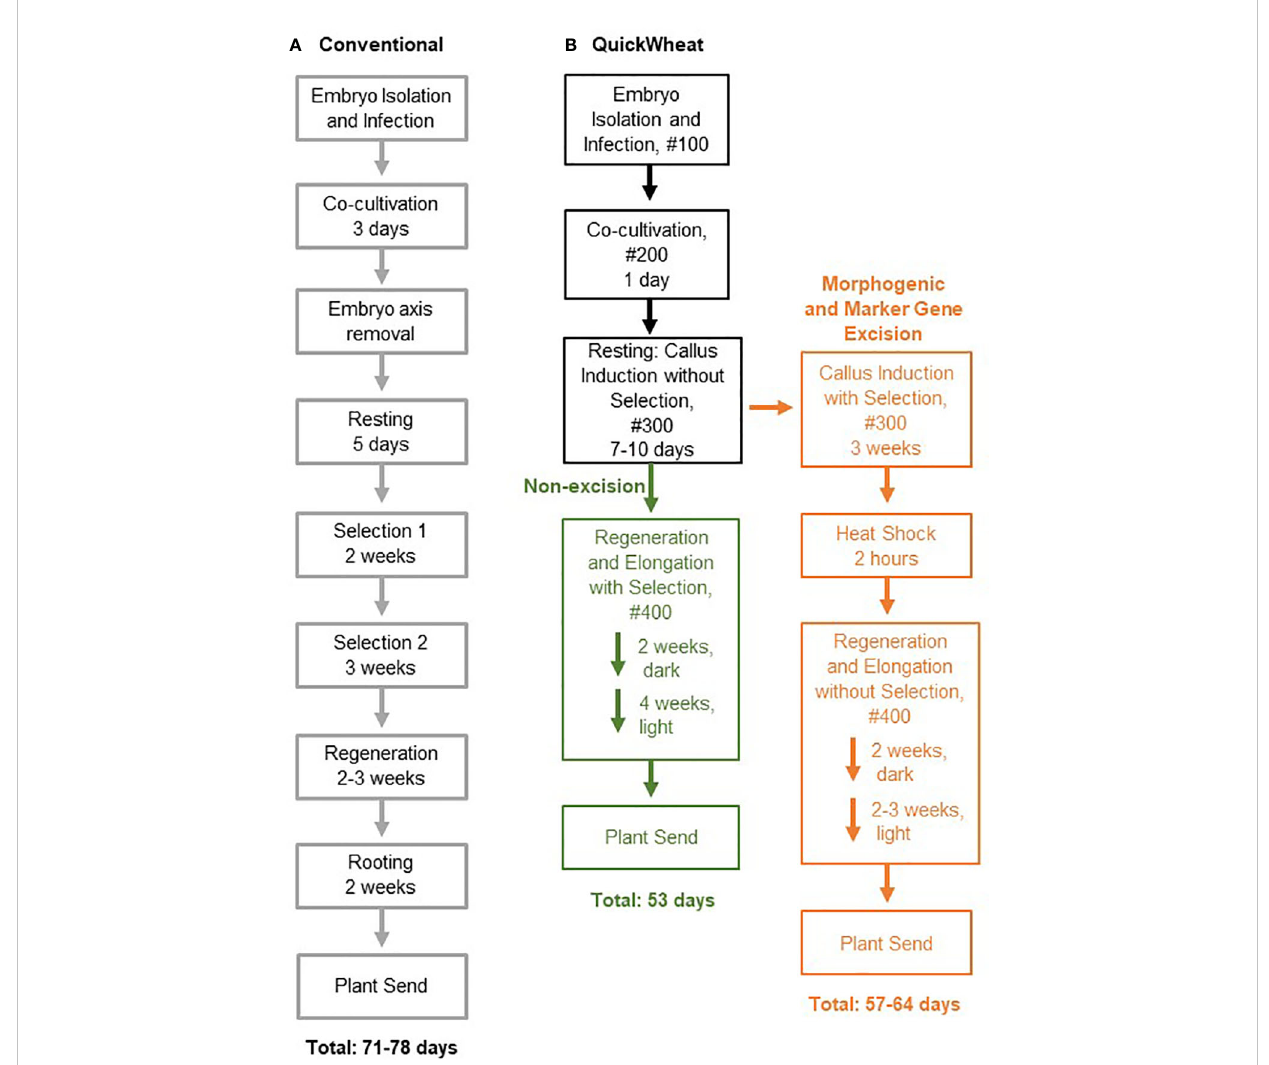
FIGURE 1 Flow chart comparing conventional wheat transformation and QuickWheat transformation procedures. (A) Conventional transformation procedure (B) QuickWheat transformation procedure either with or without morphogenic and marker gene